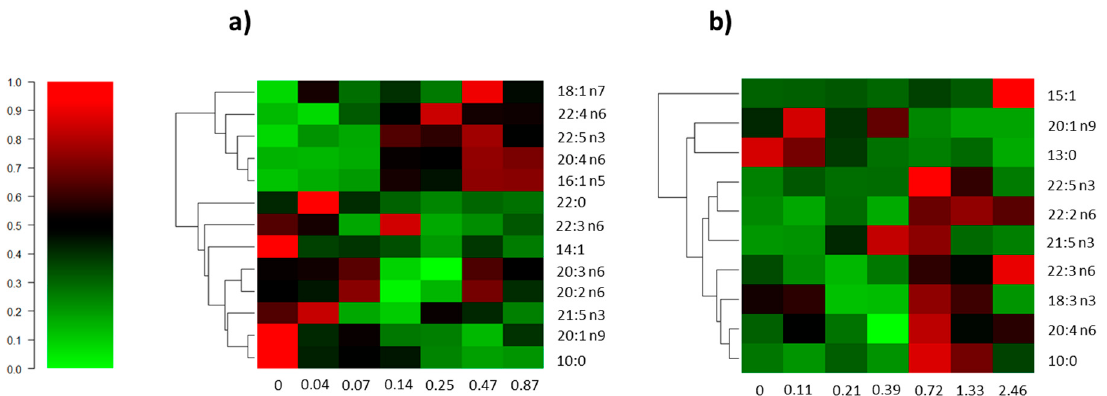
Figure 3. Heatmap depicts an overall comparison of the significantly different fatty acids in Gibbula umbilicalis ( a ) and Palaemon elegans ( b ) based on their sensitivity to different concentrations of Asparagopsis armata exudate. Rows are clustered using Bray–Curtis distances and unweighted pair group method with arithmetic mean (UPGMA) clustering method, and color scaling (relative units) was performed by row after normalization of each fatty acid to the mean of the respective control. On the XX axis are the concentrations of A. armata exudate in percentage (%).